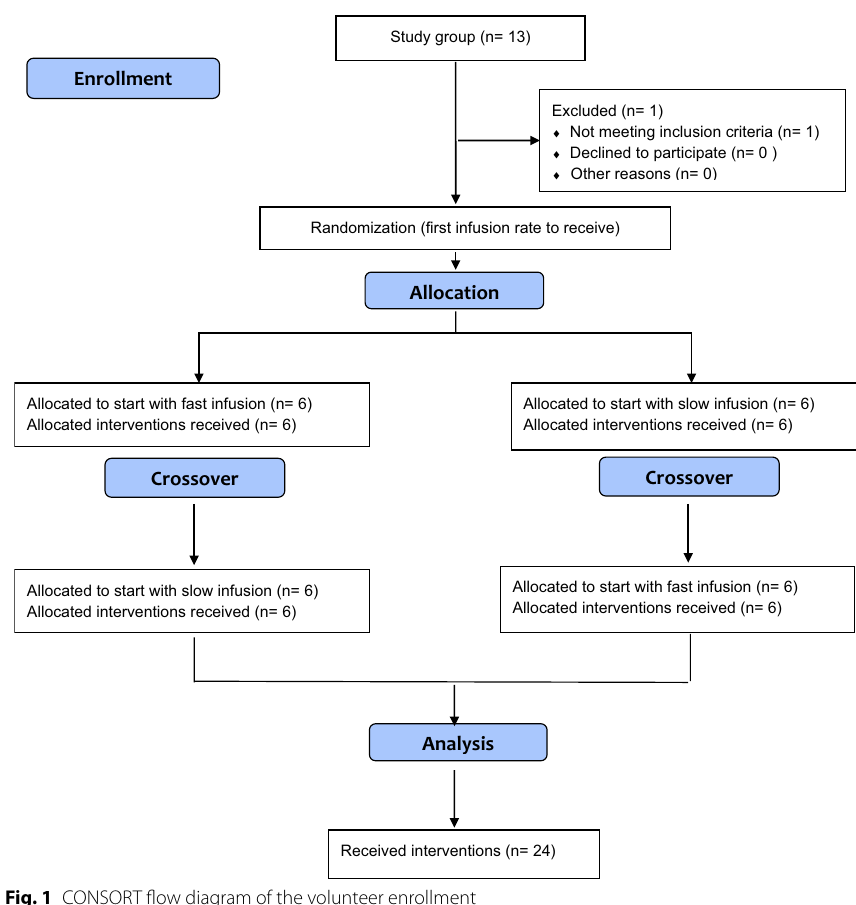
Fig. 1 CONSORT flow diagram of the volunteer enrollment